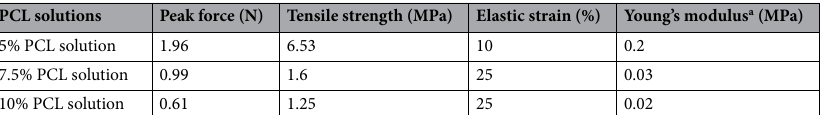
Table 1. Tensile properties of PCL solutions with different concentrations. Although the elastic strain of the 5% PCL solution is relatively low, Young’s modulus is way higher than others. a Young’s modulus: a measure of the ability of a material to resist changes in length when under tension or